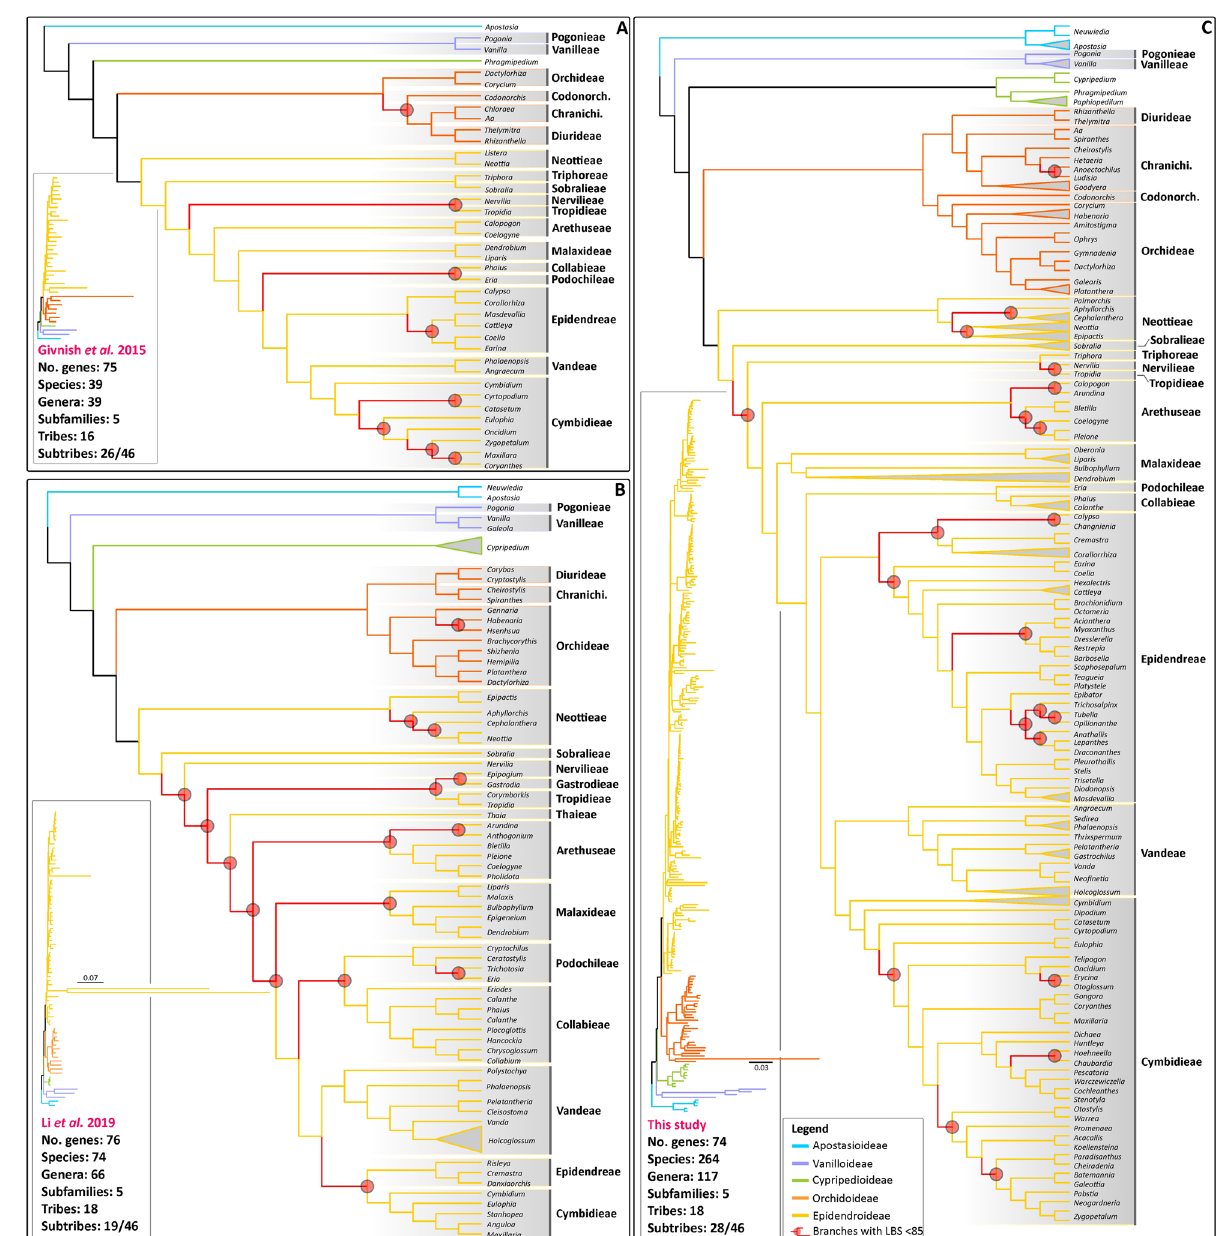
Figure 2. A comparison of the main plastid topologies of the orchid family published to date. ( A ) Givnish et al. 2 inference based on 75 plastid genes and 39 orchid species; ( B ) Li et al. 28 inference based on 76 plastid genes and 76 orchid species; ( C ) This study: 78 plastid and 264 orchid species. LBP at nodes are highlighted in red together with their corresponding subtending branches. (Inset): trees with branch lengths proportional to substitutions/